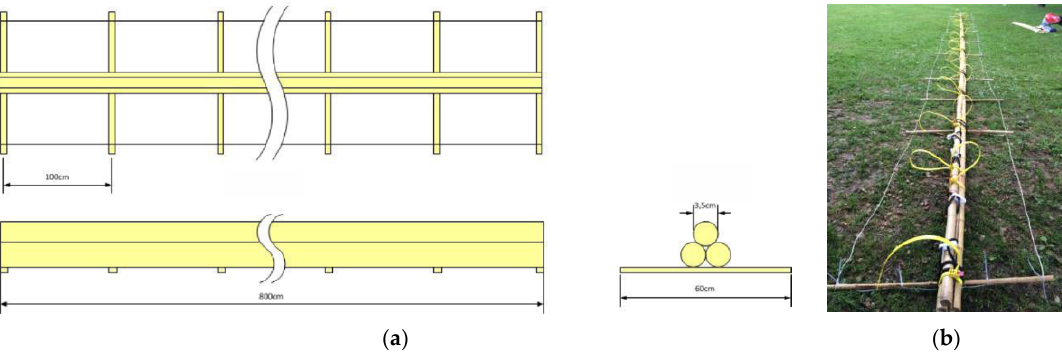
Figure 3. Layout of the floating antenna coil construction with a bamboo core; ( a ) View along all three directions; ( b ) Picture of the built device.